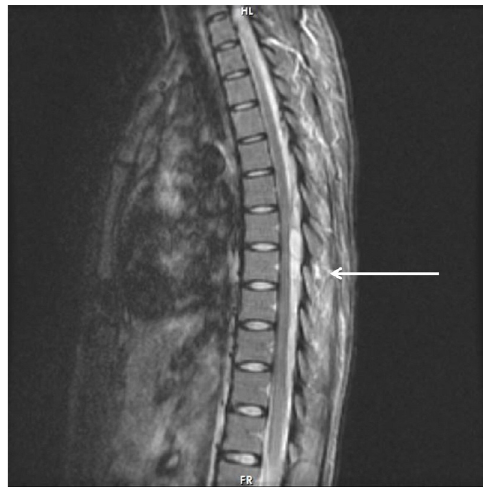
Figure 2. STIR sequence showing hyper-intensity in the interspinous